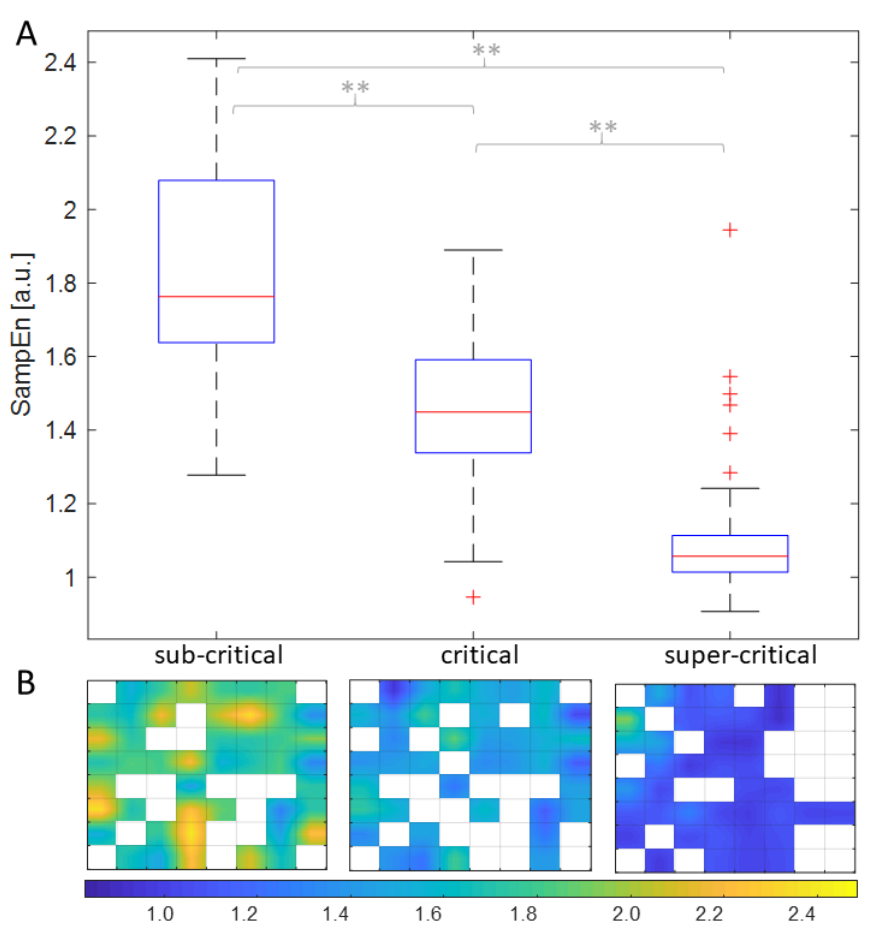
Figure A1. Same as Figure 2, but showing SampEn instead of ApEn. ( A ) Single electrode SampEn distributions estimated from the three cultures used in our experiment correspondent to sub-critical, critical, and super-critical dynamics. The asterisks indicate the statistical difference assessed by a Mann–Whitney U-test followed by a Bonferroni correction (** means p < 0.01). ( B ) Colour maps of the Micro-Electrode Arrays, providing the spatial distribution of the ApEn